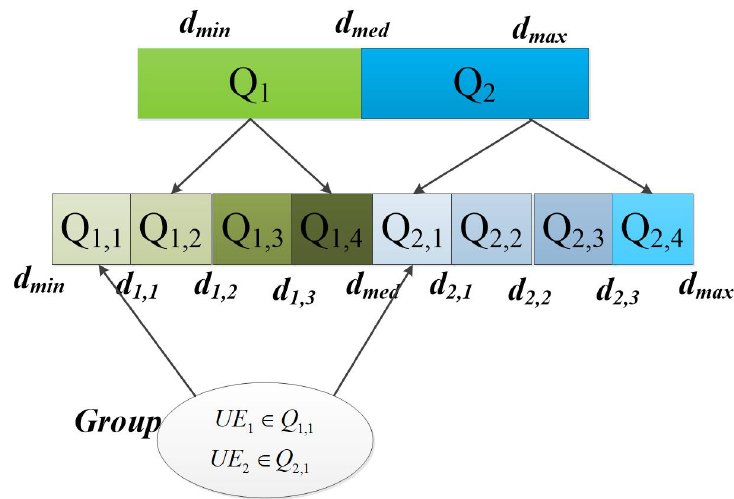
Figure 5. User pairing for uplink